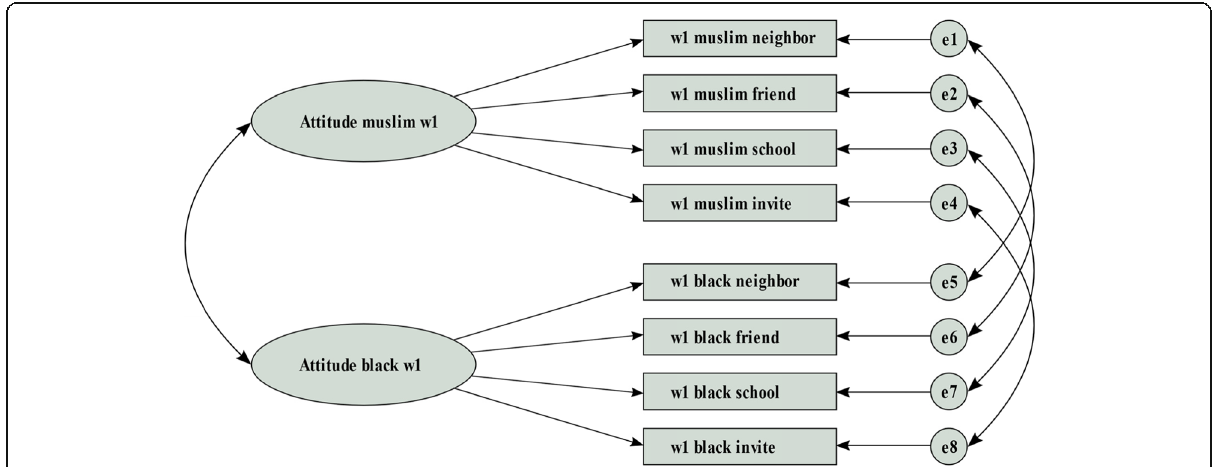
Fig. 3 Simultaneous factor analysis of attitudes toward Muslim and black